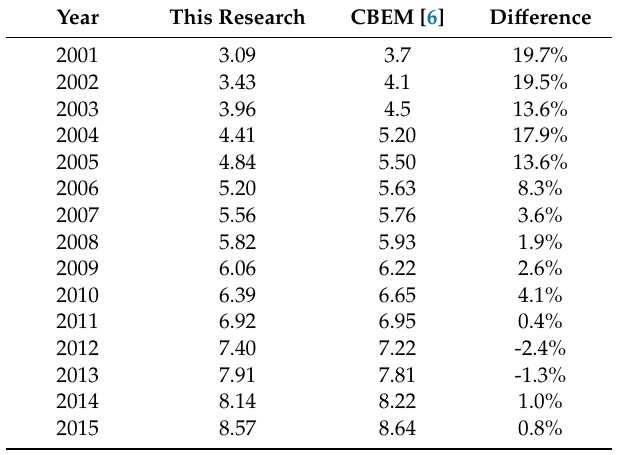
Figure 3. Changing annual growth of building energy consumption 2001–2015. Data source: data on building floor area [19]. Table 2. Data comparison between this research and CBEM, in 100 million tce.